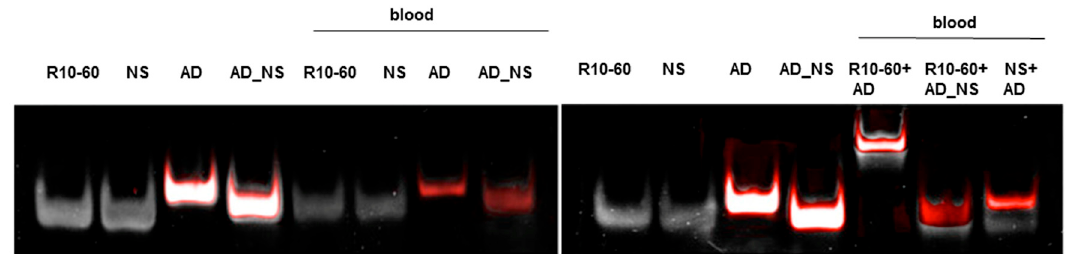
Figure 4. Analyses of specific binding of R10-60 antidote (AD) to the R10-60 aptamer in whole human blood and the formation of aptamer/AD complexes using 10% nondenaturing polyacrylamide gel electrophoresis. Blood was first incubated for 2 min with 5 µ g R10-60. Subsequently, 5 µ g R10-60 (AD) was added and incubated for 2 min. After isolation of oligonucleotides, samples of 10 µ L were analyzed. NS and AD_NS were used as negative controls. Firstly, FAM-labeled ADs were detected using an UV-transilluminator (red colored bands) and then all oligonucleotides were detected using GelRed™ staining (white colored bands). An overlay of FAM and GelRed staining is presented. NS: R10-60 (NS), AD: R10-60 (AD) FAM, AD_NS: R10-60 (AD_NS) FAM.